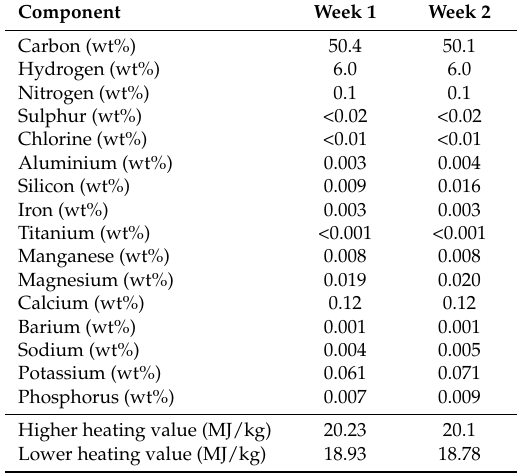
Table 2. Elemental analysis of two fuel samples. The measured data is for dry fuel and balance should be oxygen. The reported ash content was 0.5 wt% for both samples, including